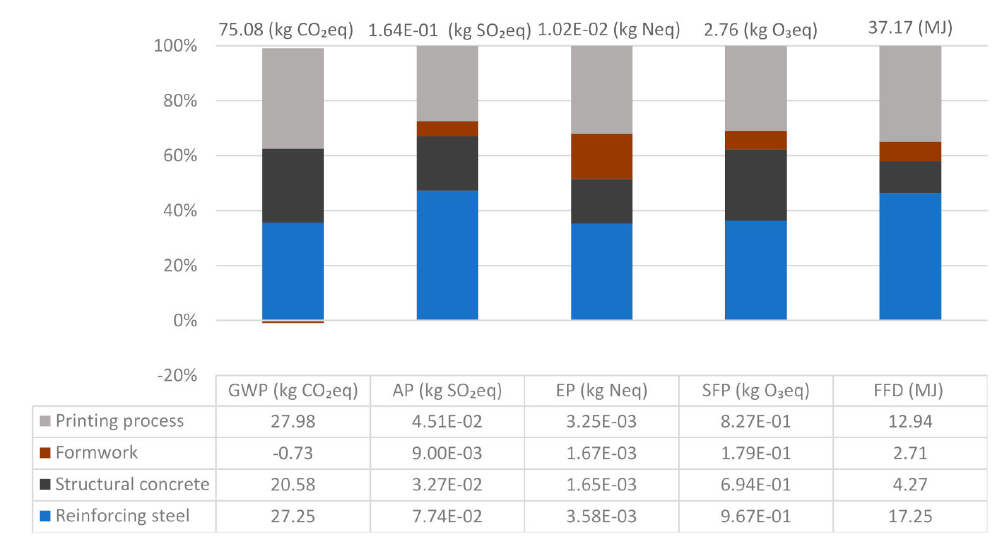
Figure 9. Detailed contribution of the di ff erent materials in